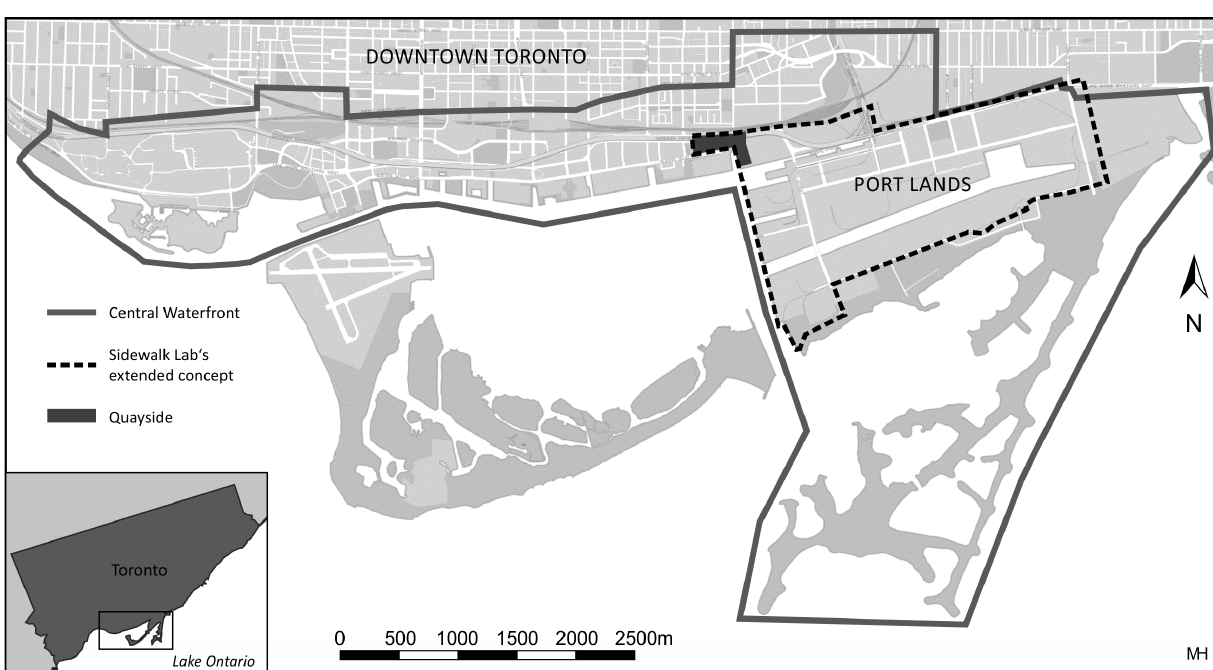
Figure 1. Downtown Toronto waterfront (map by Malte Helfer,